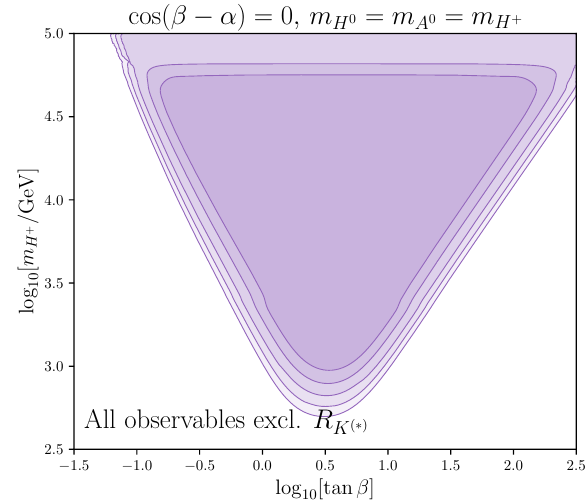
Figure 18. Contour plot of the allowed 2HDM-II parameter space in the (tan β − m obtained by combining all observables excluding R , fixing the additional parameters as cos( β − K ( ∗ ) α ) = 0 , m = m = m . The contours indicate the allowed parameter space at 1 , 2 , 3 , 4 , 5 σ H + H 0 A 0 confidence level going from darker to